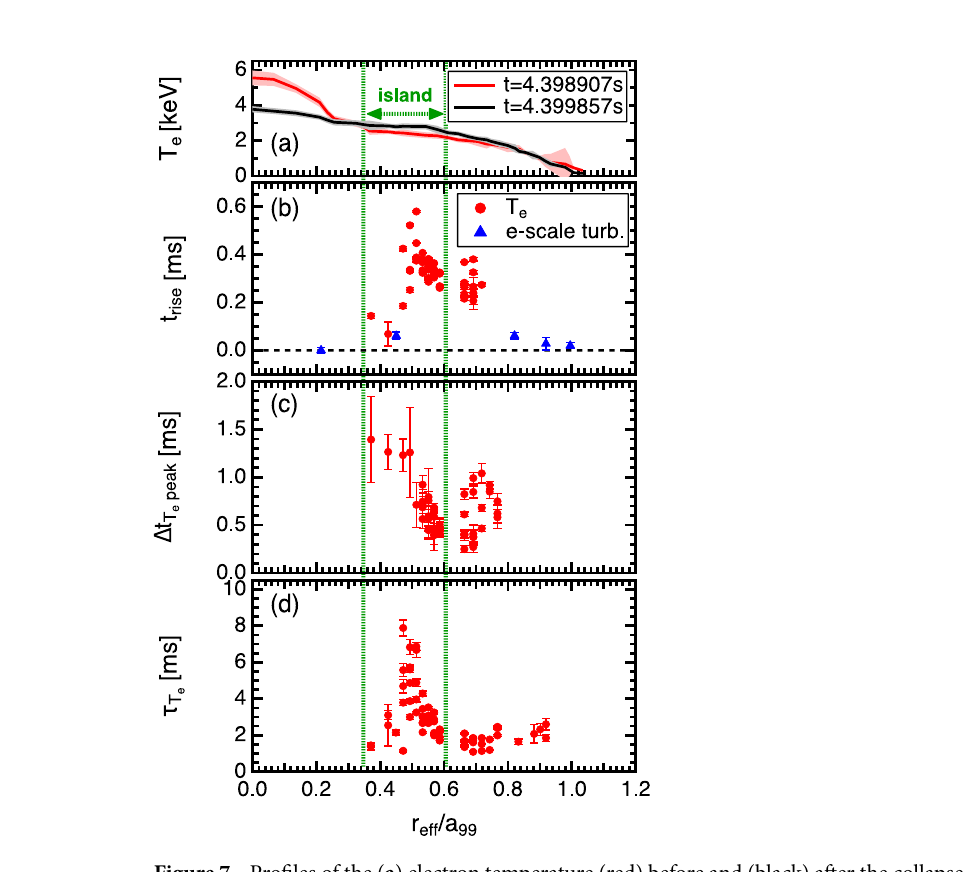
Figure 7. Profiles of the ( a ) electron temperature (red) before and (black) after the collapse of the e-ITB, ( b ) rise time of the electron temperature and electron scale turbulence, ( c ) interval between the rise time and peak time of the electron temperature, and the ( d ) decay time of the electron